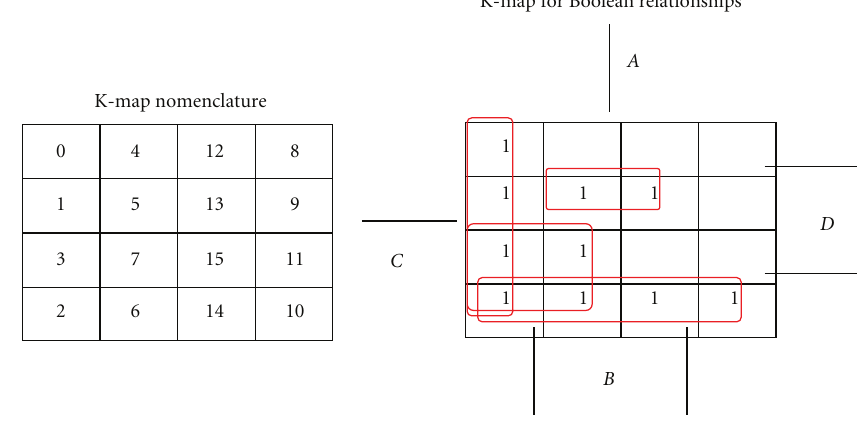
Figure 1: K-map of data represented by Table 5.